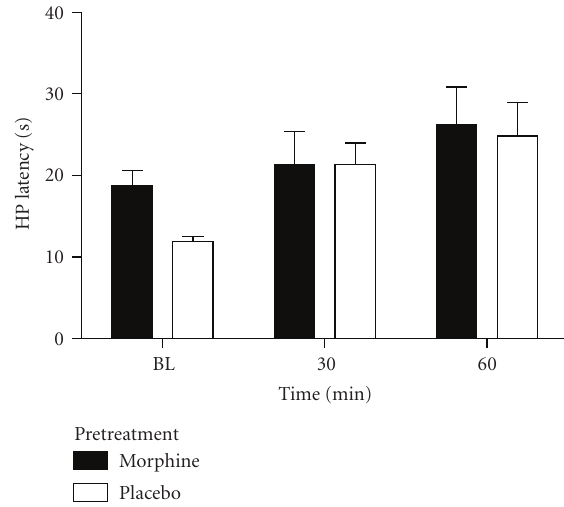
Figure 3: Decrease in locomotion following microinjection of Figure 4: No change in nociception following deltorphin microin- deltorphin into the vPAG. Microinjection of deltorphin (1 μ g/0.5 μ l) jection into the vPAG in rats treated with continuous morphine. into the vPAG caused a decrease in locomotion in rats pretreated Rats implanted with morphine pellets 3 days prior to this test had with morphine ( N = 13 and 9 for rats pretreated with 10 and higher baseline hot-plate latency than rats implanted with placebo 20mg/kg) compared to rats pretreated with saline ( N = 11). This pellets indicating that tolerance to the antinociceptive e ff ects was decrease in activity is caused by a change in normal behavior to lying not complete. Microinjection of deltorphin into the vPAG caused and crouching in the cage following deltorphin administration (see an increase in hot-plate latency in rats with placebo pellets ( N = 5), Table 1). but did not increase the hot-plate latency for rats with morphine pellets ( N = 5) above the baseline latency. That is, there was no additional antinociception by injecting deltorphin into the vPAG of Table 1: Percentage of rats showing normal and abnormal behavior rats receiving following deltorphin microinjection into the vPAG in morphine- pretreated rats. Crouching/lying